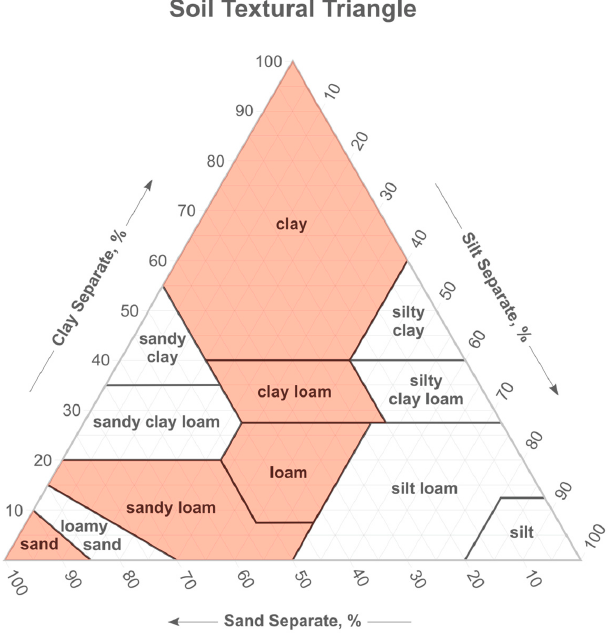
Figure 3. Subsurface types used in the analysis as seen in the soil textural triangle, modified from [39]. Table 2. Subsurface types used in the model, related to the 𝐷 (cid:3047)(cid:3052)(cid:3043) , 𝑈 (cid:3047)(cid:3052)(cid:3043) and 𝐿 (cid:3047)(cid:3052)(cid:3043) parameters. The subsurface type is linked to the hydraulic conductivity ( 𝐾 (cid:3046)(cid:3028)(cid:3047) ), drained cohesion ( 𝑐′ ), effective friction angle ( 𝜙 ), the bulk unit weight ( 𝛾 ) and the saturated bulk unit weight ( 𝛾 (cid:3046)(cid:3028)(cid:3047) ).